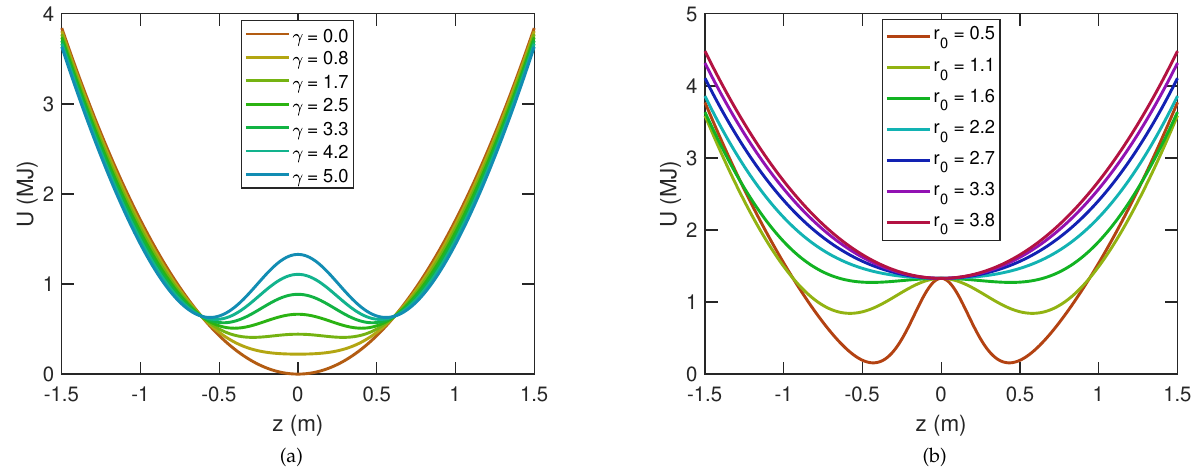
Fig. 4. Examples of how varying the bistable parameters may change the potential energy profile of the system: (4a) the impact of γ variations for r 0 = 2 m, and (4b) the impact of r 0 variations for γ = 2 .